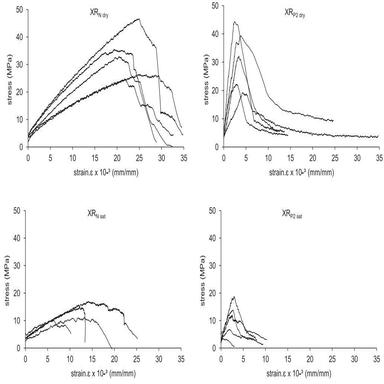
Stress–strain diagrams for XR schists tested under dry (above) and saturated (bellow) conditions.